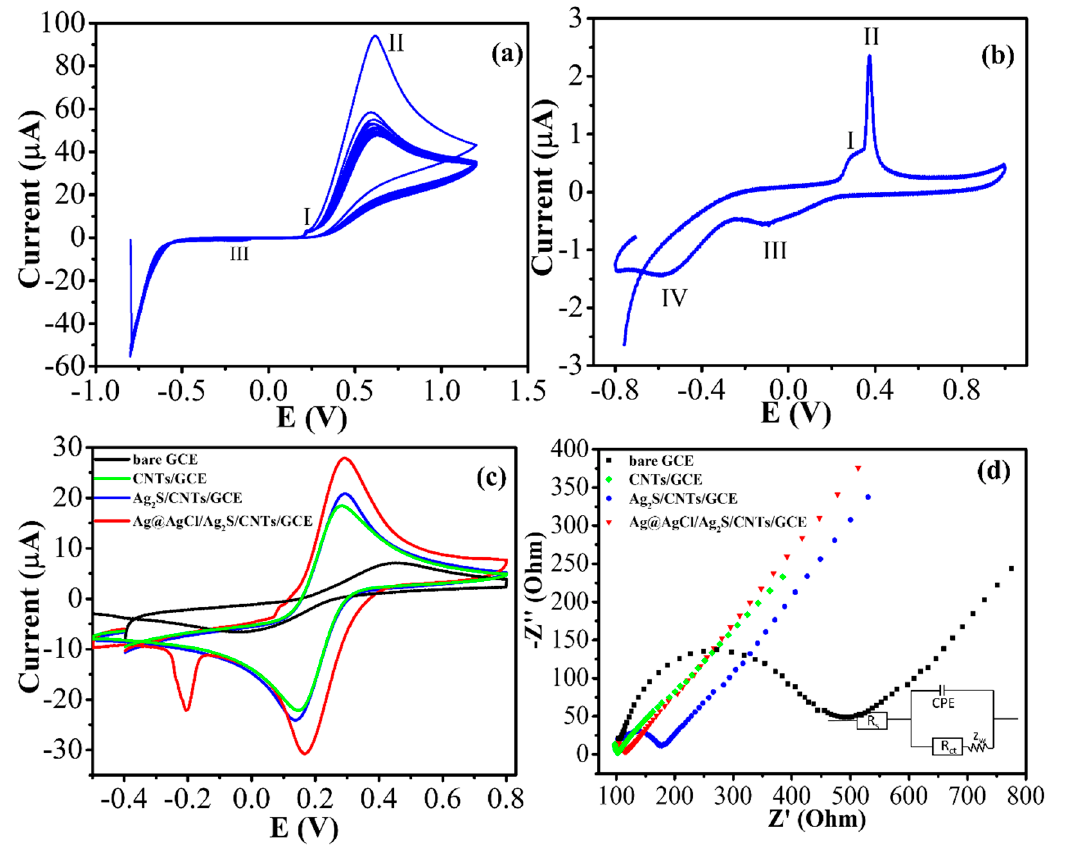
Figure 2. ( a ) Cyclic voltammograms (CVs) of the Ag 2 S/CNTs/GCE in 0.1 M KCl containing 1% ( w/v ) ascorbic acid and 5 mM of AgNO 3 at 20 mV ⋅ s − 1 ; ( b ) CVs of the Ag@AgCl/Ag 2 S/CNTs/GCE in 0.1 M phosphate buffer, pH 7 at 100 mV ⋅ s − 1 ; ( c ) CVs obtained by the bare GCE, and the modified electrode in 0.1 M KCl containing 5 mM [Fe(CN) 6 ] 3–/4 ; ( d ) EIS curves of the bare GCE, and the modified electrode in 0.1 M KCl containing 5 mM [Fe(CN) 6 ] 3–/4 − . Amplitude: 5 mV, Frequency: 0.1 Hz to 1000 kHz